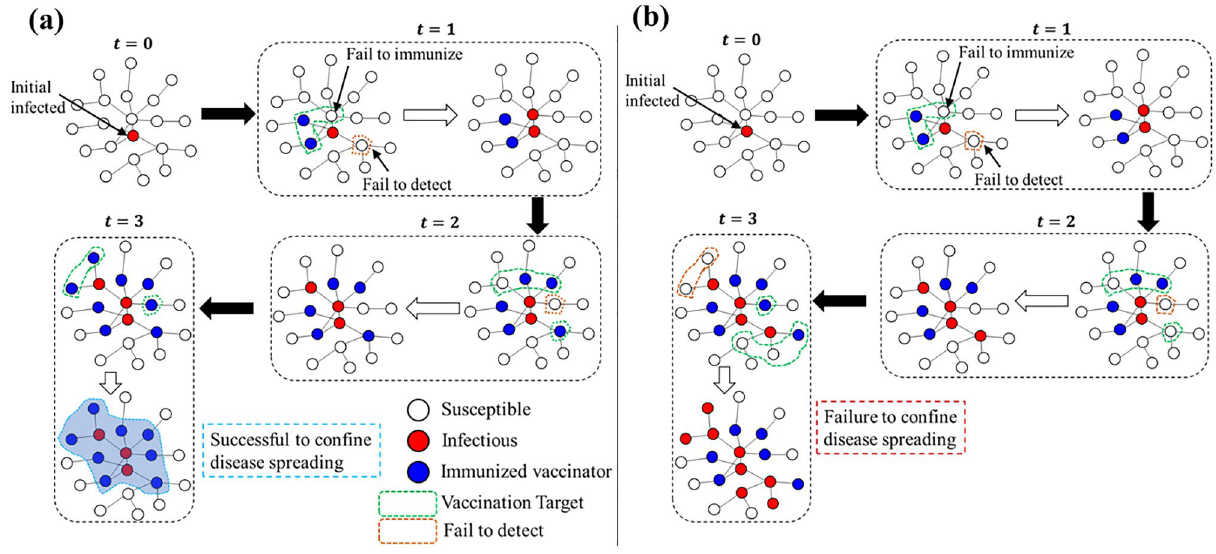
Figure 1. A schematic of the dynamic vaccination policy on a complex network. Here we portray two possible scenarios: success (panel a ) or failure (panel b ) to control the disease diffusion. The initial infection occurs at time t = 0 . The vaccination campaign starts in the next time step ( t = 1 ) by detecting susceptible individuals in the first neighborhood. However, all neighbors may not be traced due to information error (enclosed by orange- colored dashed line). Detected neighbors (enclosed by green dashed line) are given vaccination. A portion of the vaccinee fails to immunize due to vaccine failure. These issues may cause the infection to spread through the network. Depending upon the extent of vaccine efficacy and detecting error, there is a possibility of successful (panel a ) or failed (panel b ) confinement of the disease spreading.